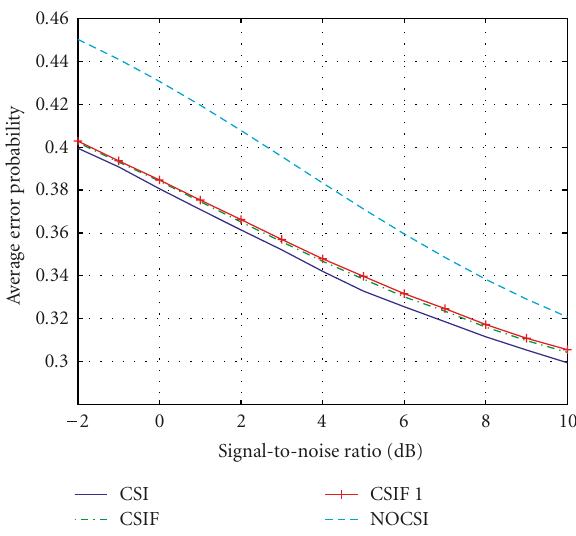
Figure 2: Average error probability versus channel SNR for identi- cal channel